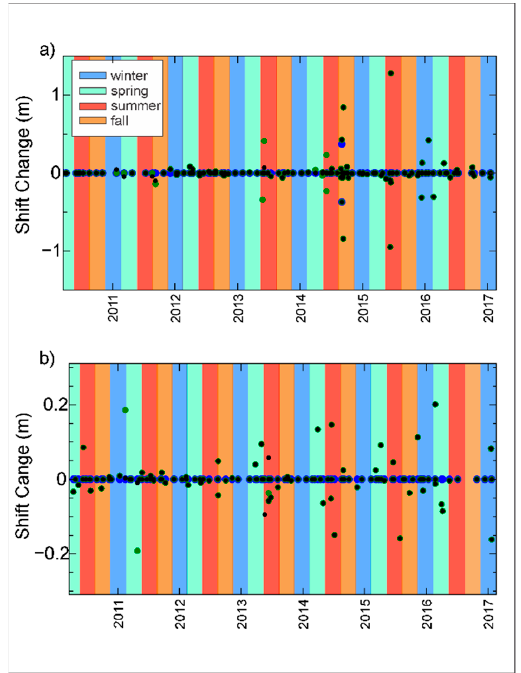
Figure 13. Shift variation value as function of the season. Black, green and blue dots represent the shift values applied to the section, channel, and overbank control areas, respectively ( a ) West Nishnabotna River near Riverton; ( b ) Shell Rock River at Rockford. Hydrology 2020 , 7 , x FOR PEER REVIEW